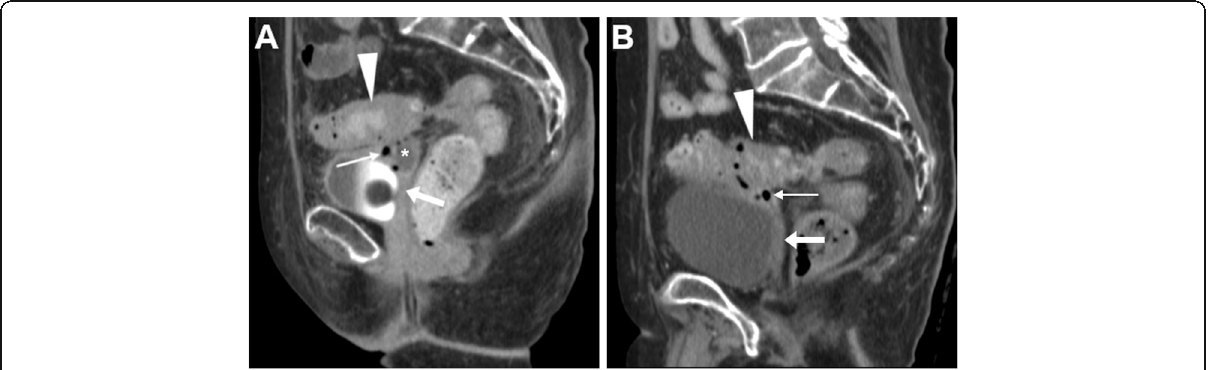
Fig. 12 Surgically confirmed colo-VF in a 76-year-old with history of hysterectomy. During acute diverticulitis and Clostridium difficile colitis, CT ( a ) shows a small-sized abscess (*) at the vaginal dome (arrow), closely abutting the thickened walls of the sigmoid colon (arrowhead), which resolves after conservative treatment ( b ). Note air bubbles (thin arrows) in the vaginal